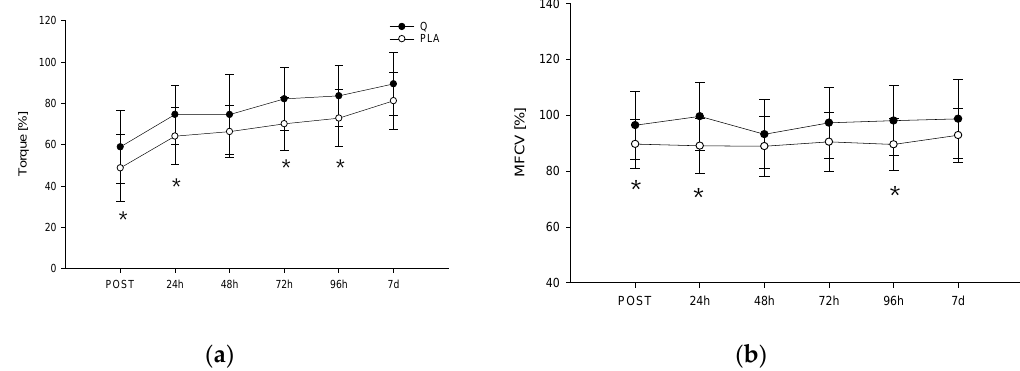
Figure 2. Torque ( a ) and mean fibers conduction velocity (MFCV) ( b ) of the maximal voluntary isometric contraction (MVIC) test in quercetin (Q) and placebo (PLA) before, after the eccentric exercise-induced muscle damage (EEIMD) and during the recovery. Data are expressed as % MVIC BASE ; mean ± SD; * ≠ from Q p < 0.05.